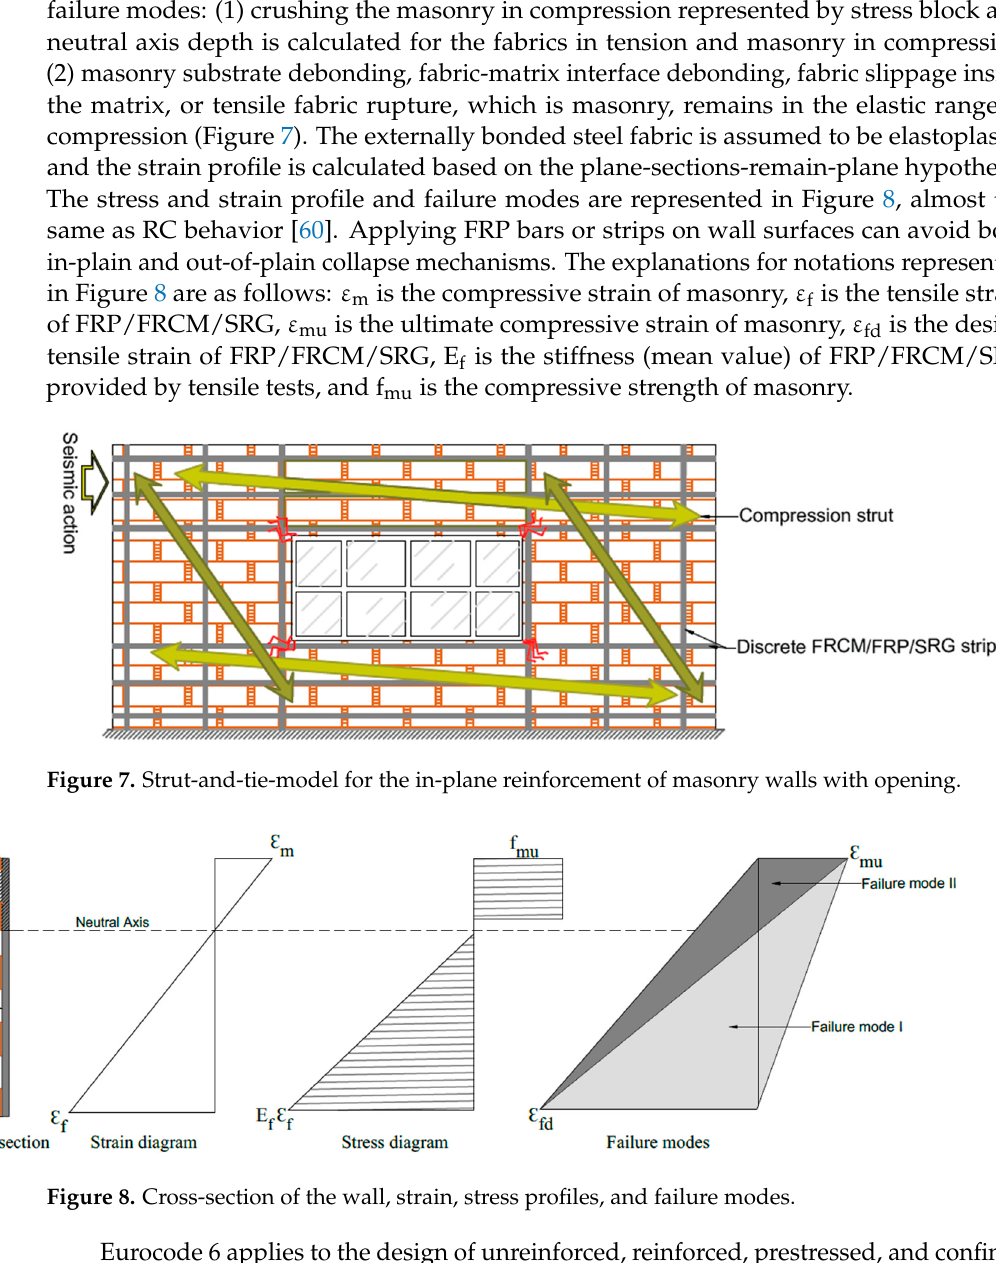
Figure 9. RM walls reinforced with steel bars, Shiraz, Iran. 4.2. Masonry Archs and Vaults Masonry domes, barrel, cross, and cloister vaults, have two stress states under load- ing: the primary phase without cracking and an ultimate cracked phase where the tensile strength vanishes. The membrane solution reasonably estimated the initial state to sustain tensile stresses, and after cracking, the ultimate state is modeled in the rigid no-tension framework. The vault stress state remains constant for a long time if loading is relatively low and if the masonry provides adequate tensile resistance. The cross vault’s transition from uncracked to cracked state is similar to masonry domes. The cracked cross vault webs are separated into some series of arches with different spans supported by the diag- onal ribs, and thrust causes the vault’s abutment deformation, span broadening, and in- creased cracking. The arch’s horizontal thrust pushes the supports outward, leading to crack formation at extrados abutments, as illustrated in Figure 10a. Due to high compres- sion forces (horizontal thrust), cracks appear in the arch abutments - Figure 10b shows